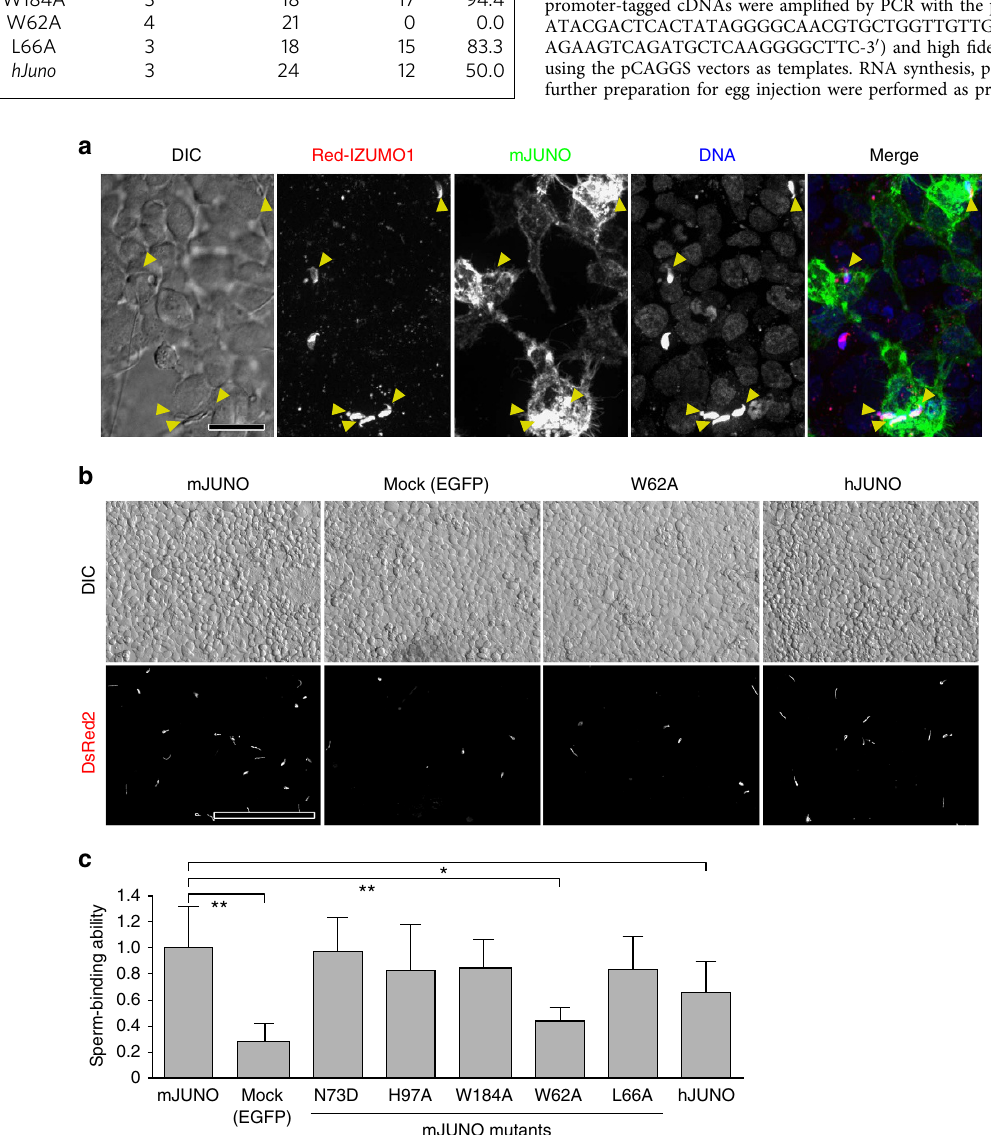
Figure 4 | Sperm binding to JUNO-expressing cultured cells. ( a ) Z-stack confocal microscopy image of seeded cells and inseminated Red-IZUMO1 spermatozoa. Red-IZUMO1, mJUNO and DNA (Hoechst 33342) signals are indicated in red, green and blue, respectively, in the merged image. The heads of spermatozoa bound to mJUNO-expressing HEK293T cells are indicated with arrowheads. Scale bar, 20 m m. ( b ) Binding of spermatozoa with mitochondrial DsRed2 to HEK293T cells expressing WT mJUNO, mutant mJUNOs or hJUNO. Light (upper image) and fluorescence (lower image) microscopic images of transfected cells after insemination with fluorescent spermatozoa are shown. Each picture corresponds to a quarter of the area of the field used for analysis. Scale bar, 200 m m. ( c ) Sperm-binding abilities of JUNO-expressing HEK293T cells. The number of spermatozoa bound to HEK293T cells expressing WT mJUNO was set to 1.0. Data are the mean ± s.d. Asterisks indicate significant differences (Student’s t -test; * P o 0.05 and ** P o